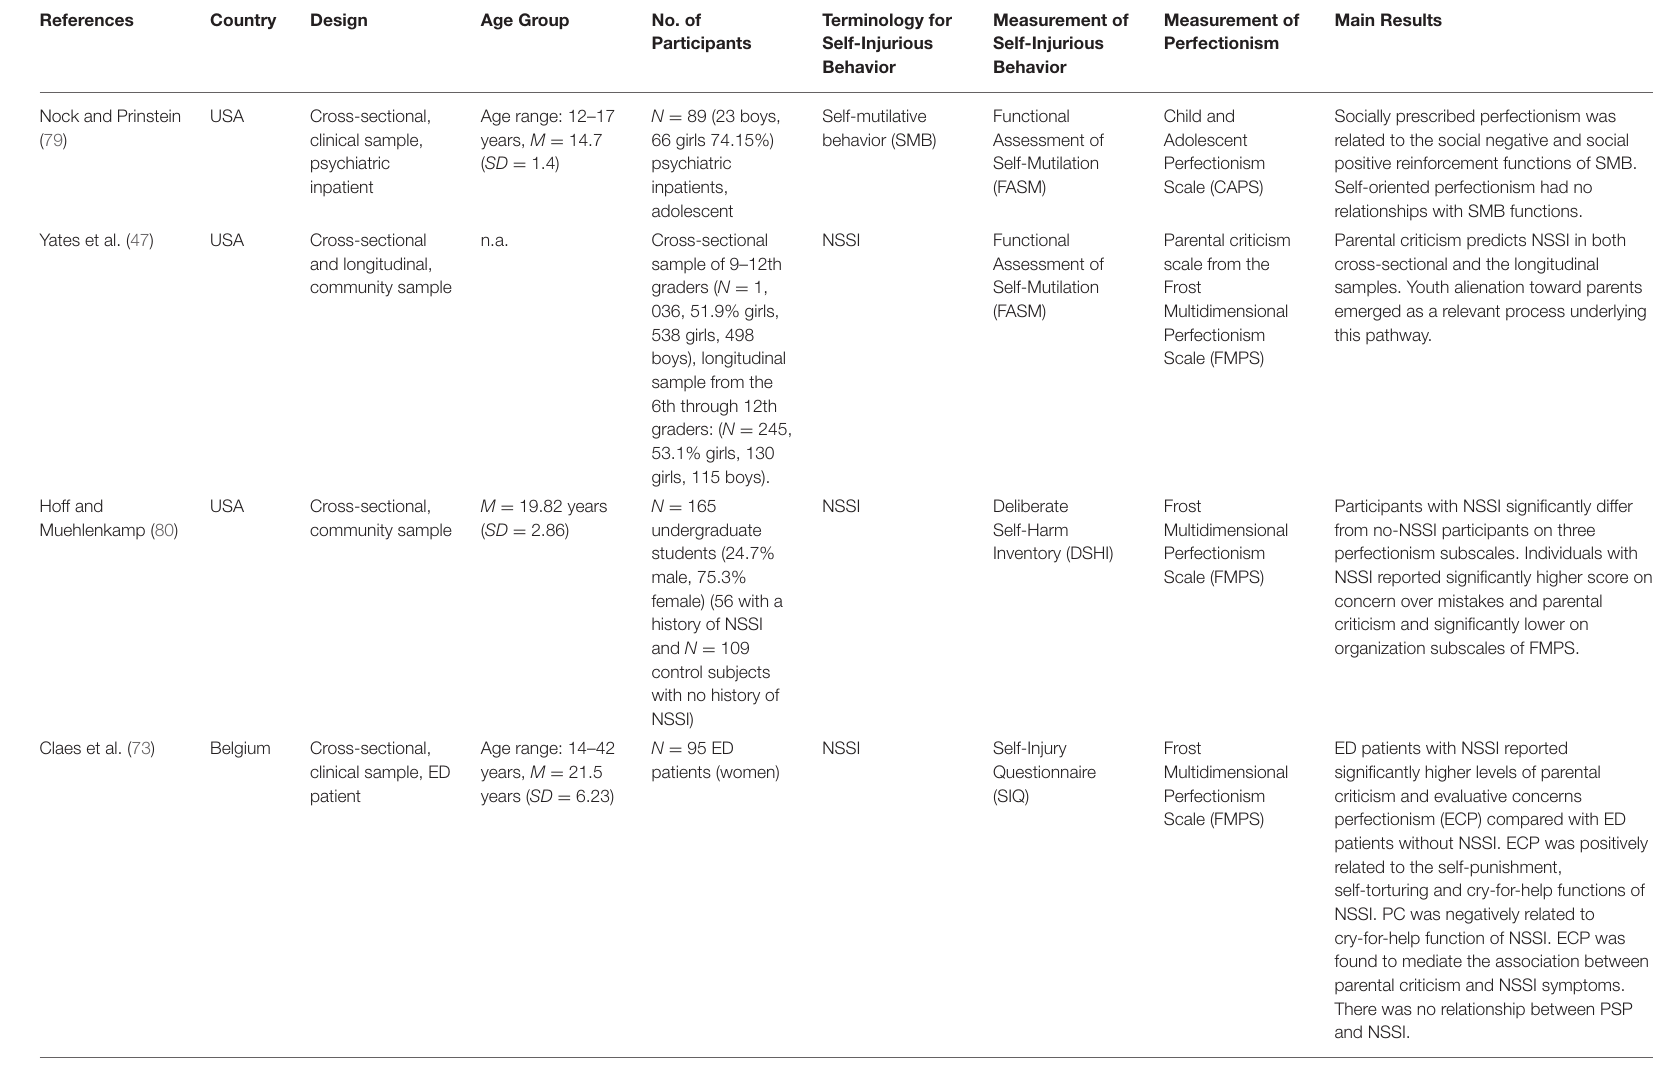
TABLE 2 | Included relevant articles ( N = 15) examining association between nonsuicidal self-injury and